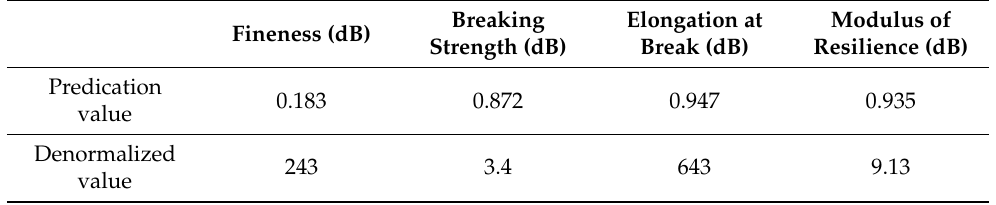
Table 6. Predicted quality data for optimal processing parameters.